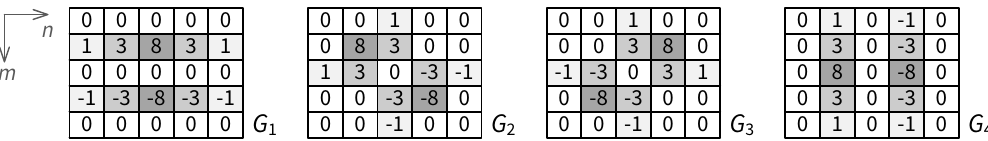
Figure 3. Directional intensity difference measurement operators G 1 – G 4